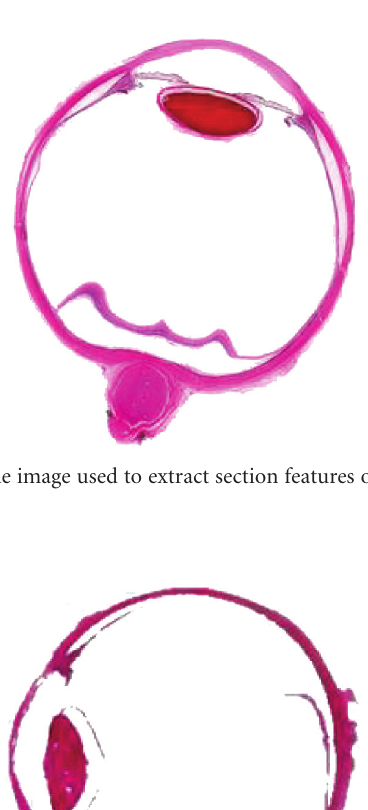
Figure 2: Human eye slice image sequence.